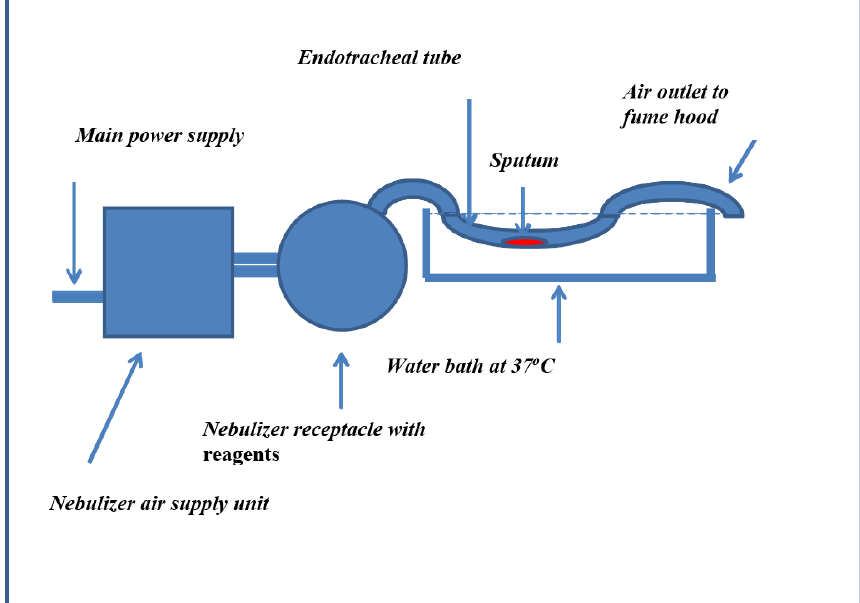
Figure 1. A schematic diagram showing the layout of equipment used in the